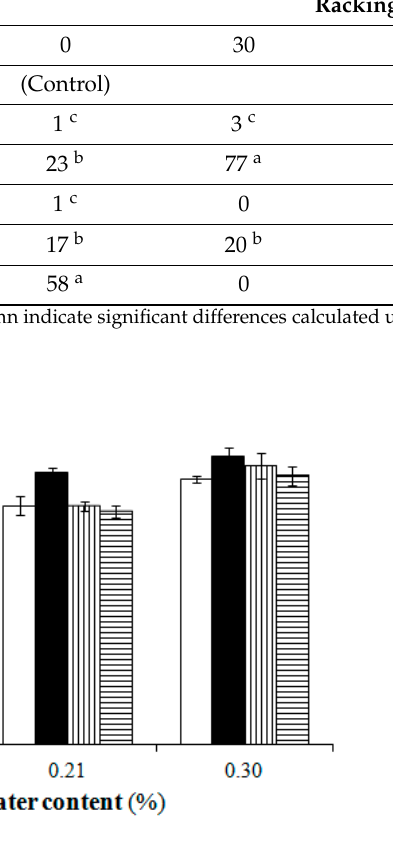
Figure 1. Survival of yeasts in Coratina monocultivar EVOO with different water contents during incubation. Time zero ( □ ); one month ( ■ ); two months ( ); three months ( ).